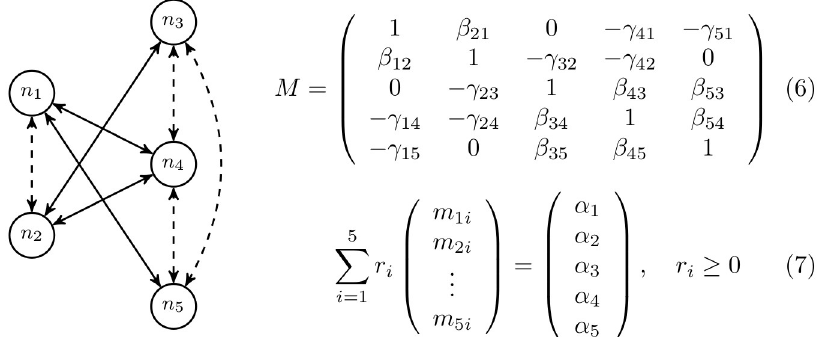
Fig 3. The cone of maximal biodiversity and structural stability. Left: Example (2 + 3)-bipartite graph with two nodes on the left and three nodes on the right. Competition (dashed lines) is between all elements on the same side, while cooperation occurs between elements on different sides for which there is an edge represented by a solid line. Cooperative relationships form a bipartite graph with two groups of nodes (left and right). Top right: Connectivity matrix − M of the system. Competition parameters β ij > 0 are set for all pairs of nodes n i , n j in the same group (both at the left or the right). Cooperation parameters γ > 0 exist for nodes n , n in different groups (one in the left and the ij i j other in the right) only when there is an arrow n i $ n j in the graph. In our experiments β ij = β ji and γ ij = γ ji . Bottom right: Equation to determine if a given point a � ¼ ð a ; ... ; a Þ 2 IR 5 is in the maximal biodiversity cone. If there exist 1 5 some r � 0, 1 � i � 5, which verify (7), then a � is in the maximal biodiversity cone of M . To ensure the existence of a i solution, the sum of the absolute values of each row or column of M (including the 1 in the diagonal) must be always lower than 2. This is equivalent to bound to 1 the sum of weights of all edges adjacent to each node of the graph (node degree bounded to 1). Given M , structural stability is defined as the proportion of points a � 2 IR 5 for which (7), has a solution. Since the cones are centred at 0, considered points can be limited to those on the surface of the IR 5 sphere of radius 1 centred at